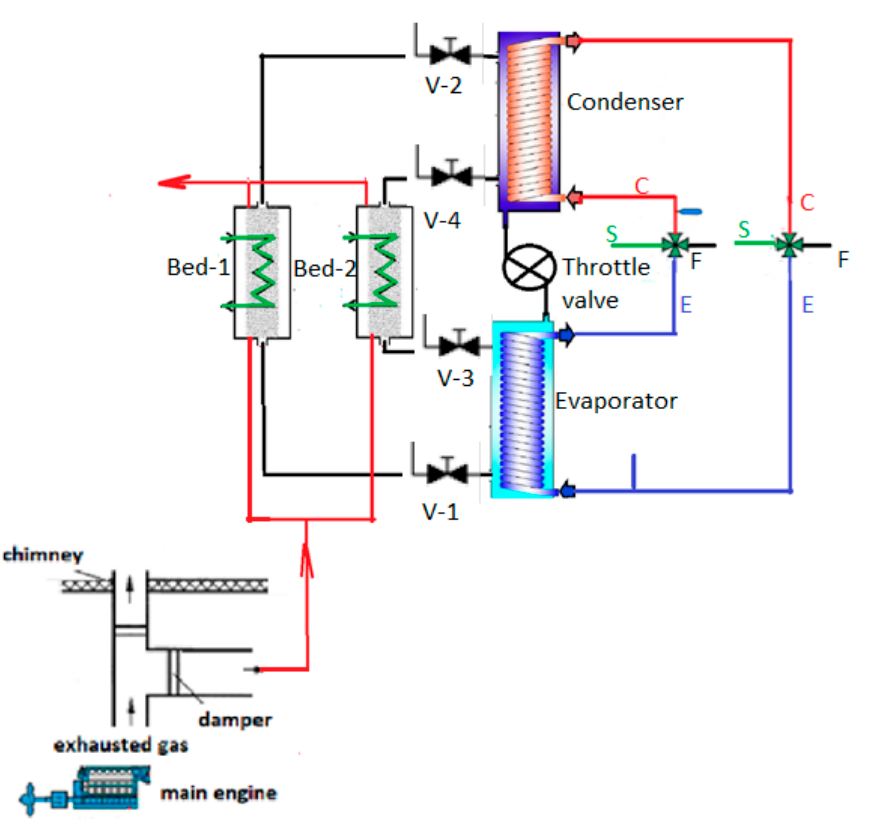
Figure 1. Onboard naval vessel cooling-adsorption and heat pump system.